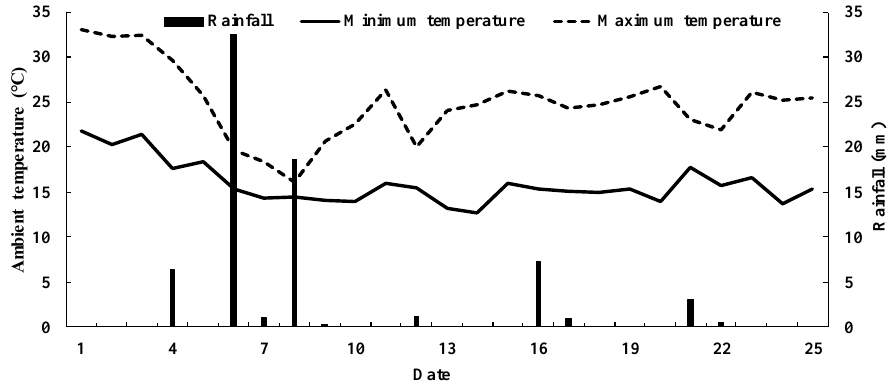
Figure 1. Daily ambient temperature and rainfall during the study.